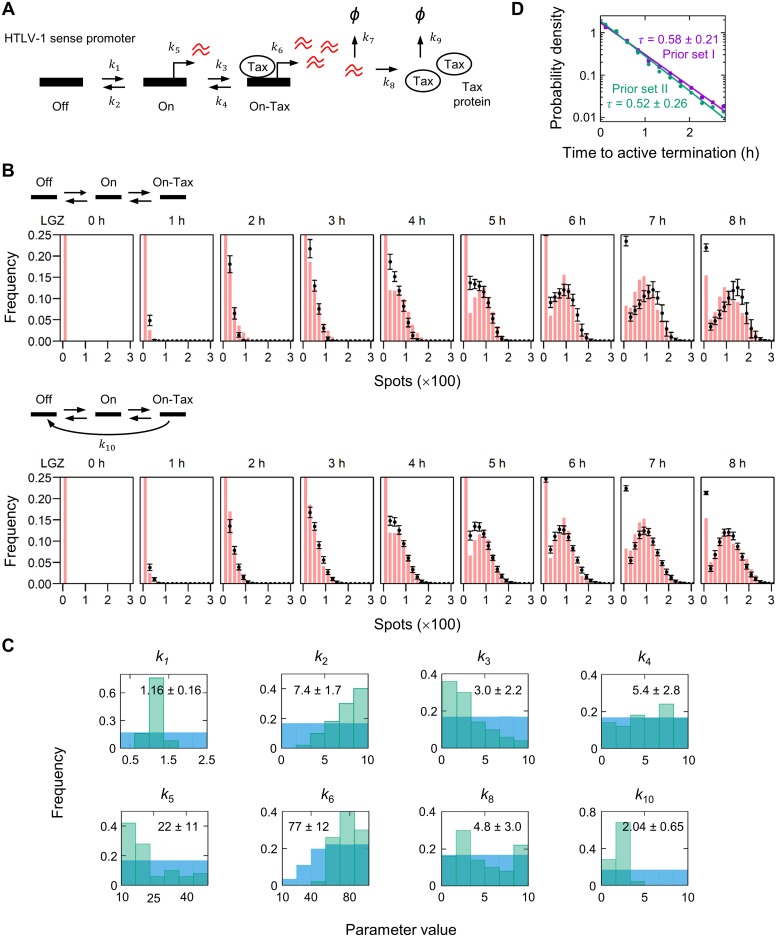
Stochastic simulation of the transient HTLV-1 expression in PBMCs ex vivo.(A) Kinetic model of HTLV-1 proviral transcription, with three promoter states: Off, On, and On-Tax. (B) Stochastic simulation of the model presented in panel A. The best 50 fits (mean and standard deviation shown in black) are superimposed on the smFISH data from the ATL patient LGZ (red bars, reproduced from Fig 2B). (C) The marginal distributions of the best 50 parameters (posterior; green bars); the respective prior distributions are shown in blue. The mean and standard deviation are indicated in the inset. (D) The interval between the initiation of the On-Tax promoter state and the direct transition from the On-Tax to the Off state in the simulation. The frequency of the interval was fitted with an exponential decay, and its probability density function is presented. The mean intervals (τ) ± standard deviation for the prior set I (Table 2) and the prior set II (S4 Fig) are indicated in the inset.